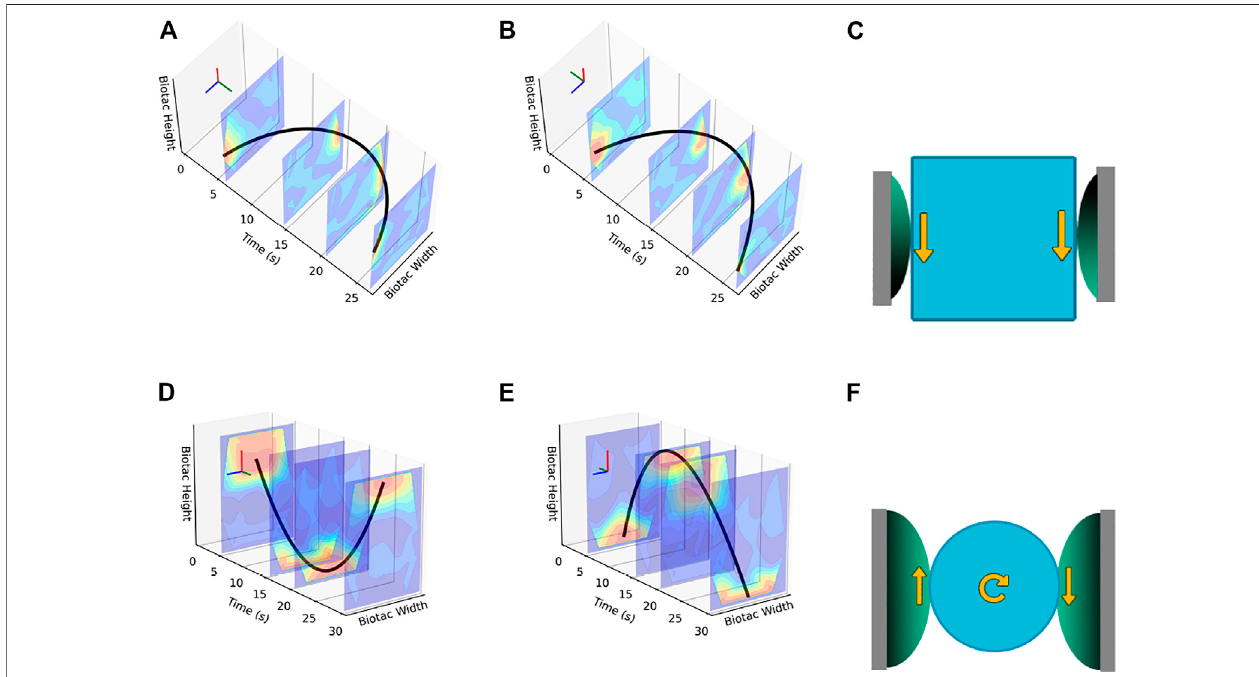
FIGURE 11 | Examples of trajectories during longitudinal and rotational slippage. (A) , (B) First Finger and Thumb trajectories for longitudinal slippage, (C) Directional Diagram for longitudinal slippage, (D) , (E) First Finger and Thumb trajectories for rotational slippage, (F) Directional Diagram for rotational slippage.